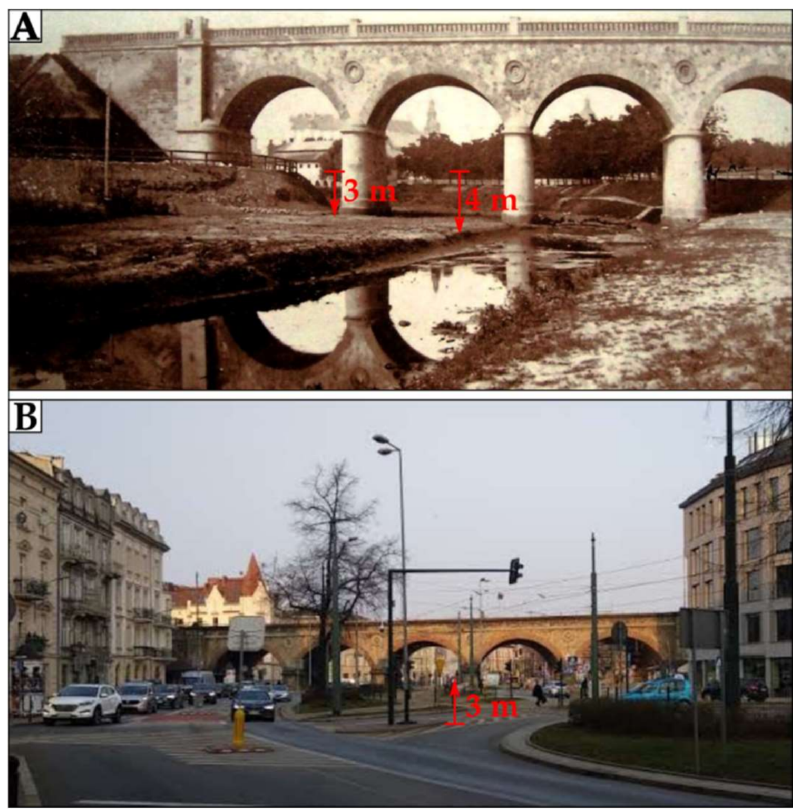
Figure 9. ( A )—One of the two Vistula channels in the centre of Krakow which used to be named the Old Vistula, shallowed with flood deposits; 3 m depth in 1870. The railway bridge is visible [64]; ( B )—the channel after intentional burning at the end of the 1870s. Because one of the city paths was created there, the surface raised by over 3 m. The former railway bridge has been operating as a railway viaduct for over 140 years. March 2021. Photo by R. Zarychta.